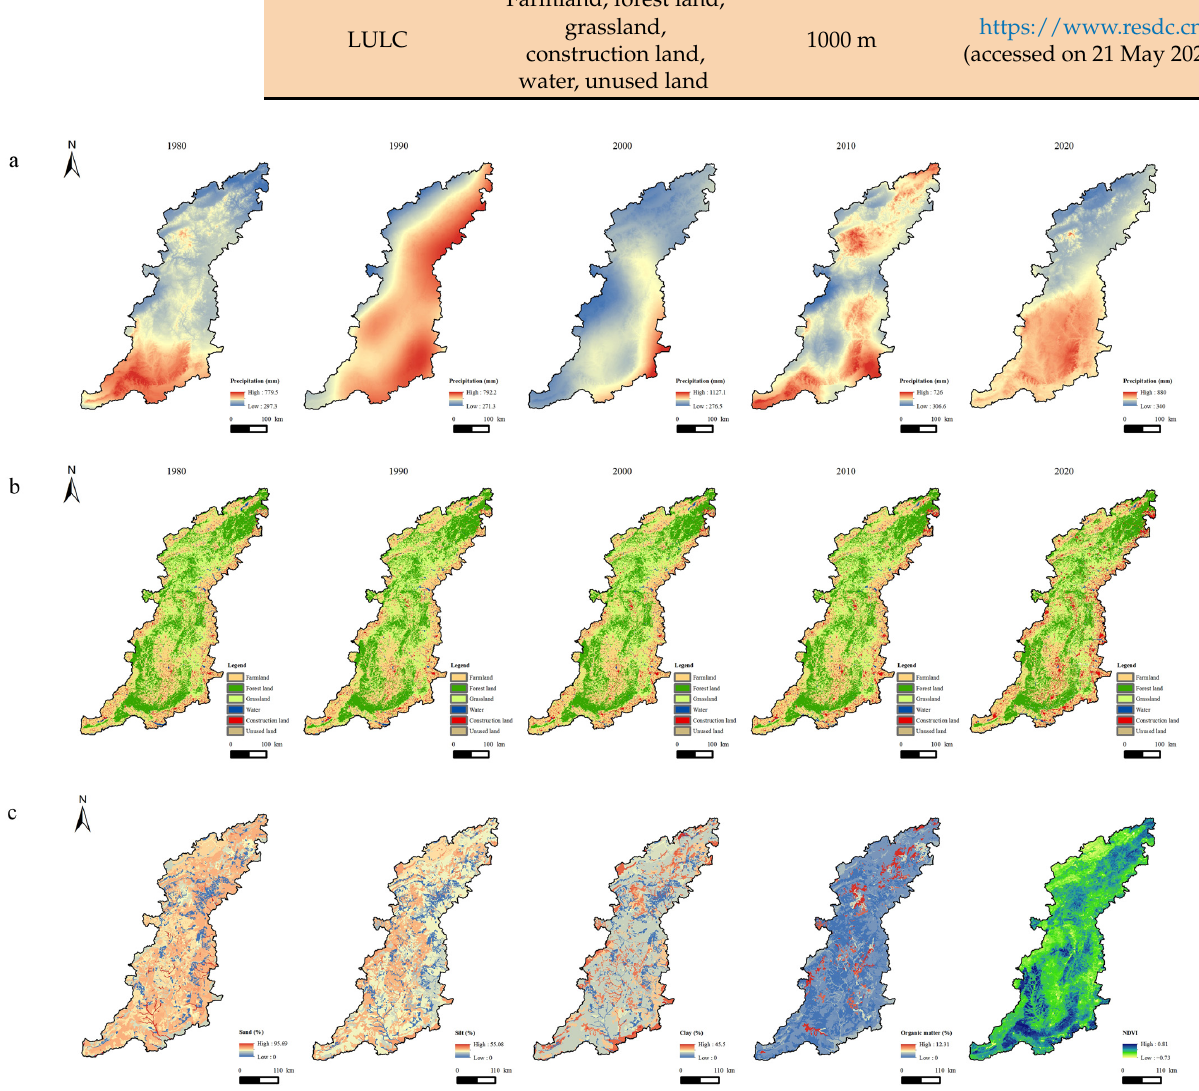
Table 1. Datasets and resources used in this study.